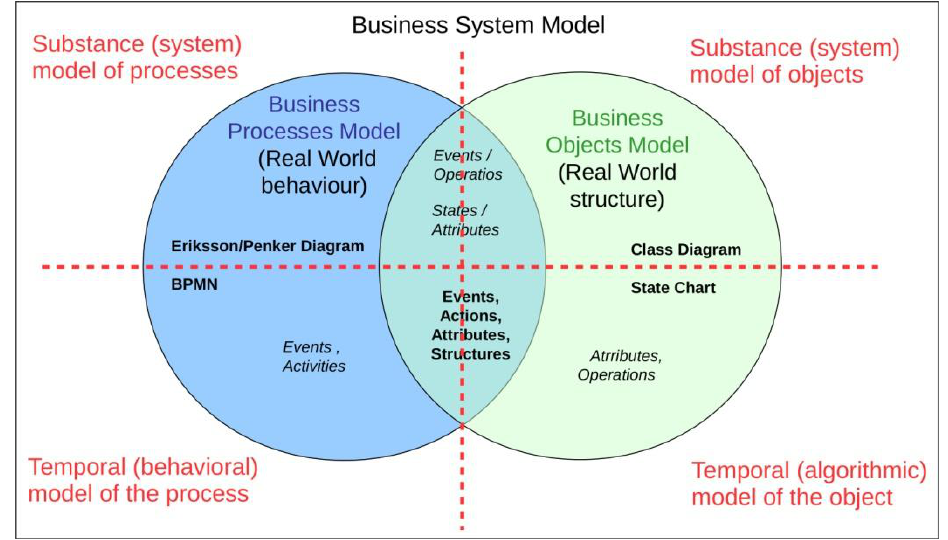
Figure 1 . Two basic types of model in two dimensions of the Real World